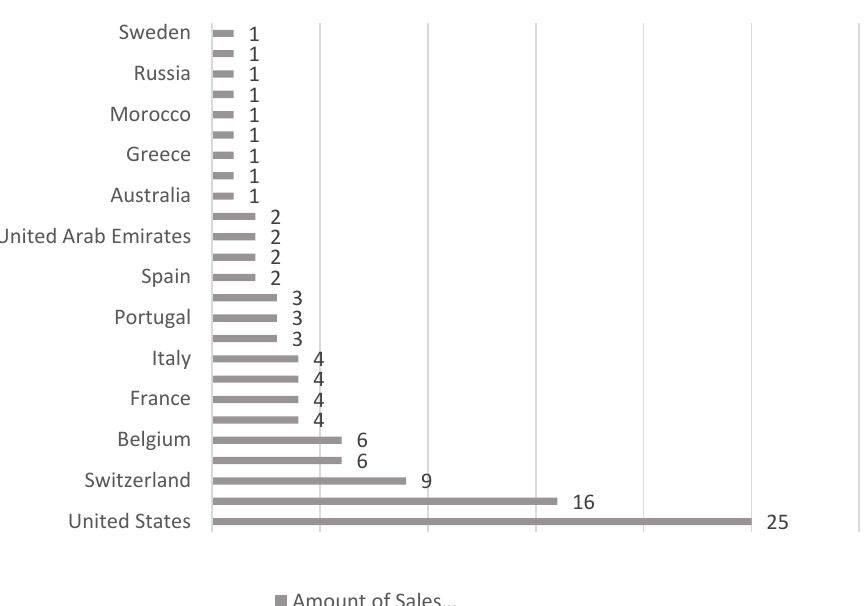
Figure 10. The destination of international sales made by Brazilian galleries (by the absolute number of galleries). Data source: Graphic designed by the author.